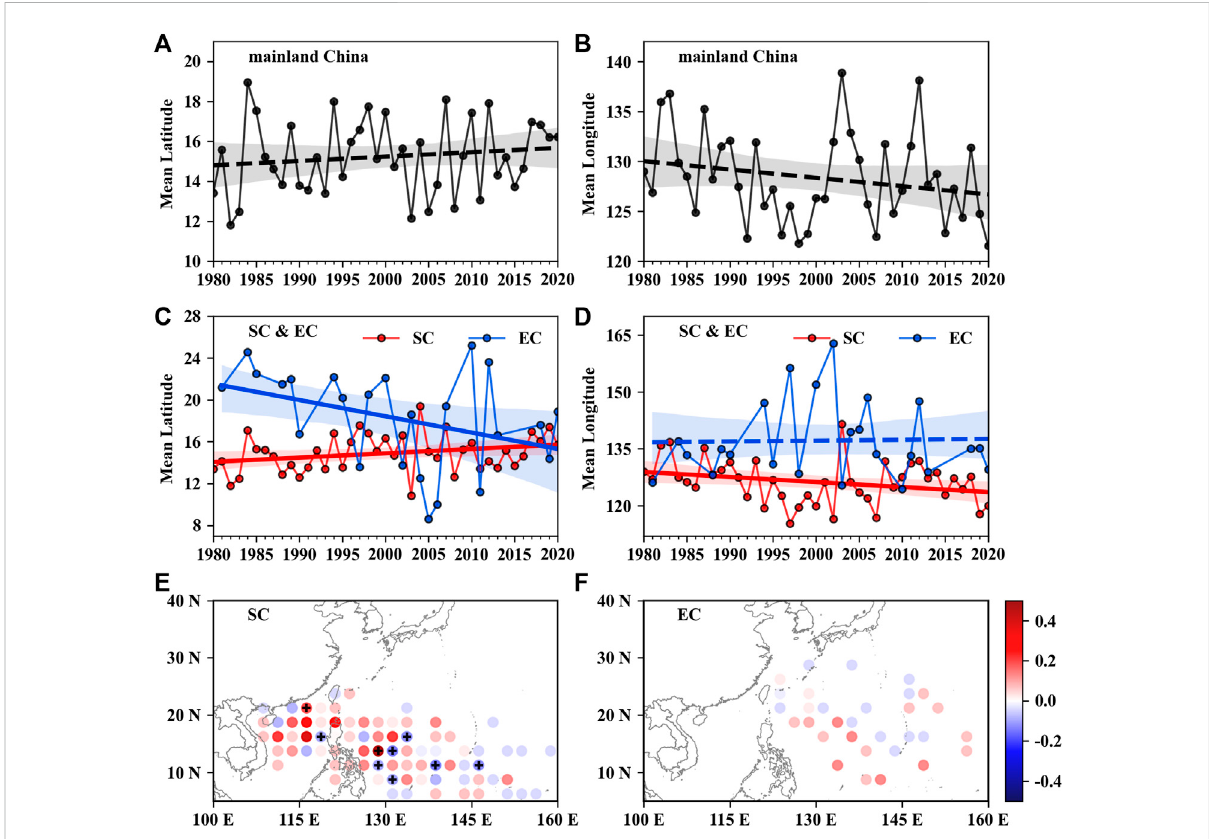
FIGURE 5 ThesameasFigure2,butfortheannualmeangenesis (A,C) latitudeand (B,D) longitudeforthelandfallingTCsovermainlandChina,SC,andEC. ThedifferenceinthegenesisfrequencyforTCslandfallingover (E) SCand (F) ECbetween1980 – 1995and1996 – 2020. Themarks ‘ + ’ indicatewhere the difference between the two periods is signi fi cant at a con fi dence level of 90%.